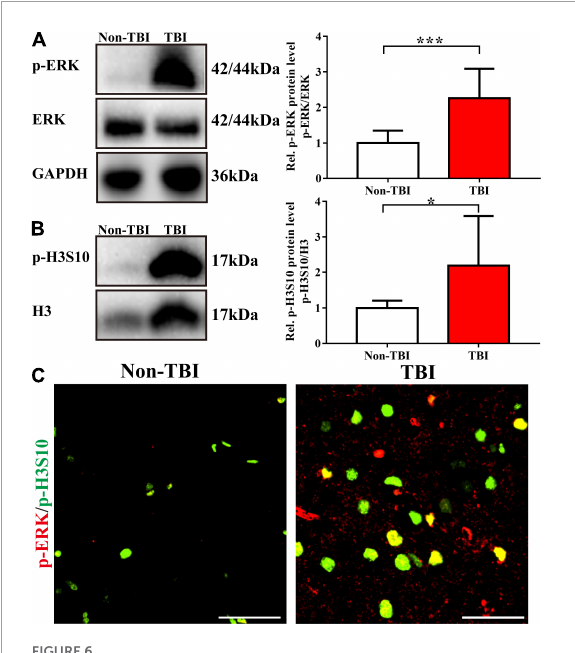
FIGURE6 Phosphorylation of H3S10 and ERK was upregulated in clinical brain specimens from patients with TBI. Western blot analysis showed that the levels of p-ERK (A) and p-H3S10 (B) in the brain tissue of TBI patients were significantly increased compared with those of non-TBI patients (For TBI patients, n = 11; for non-TBI patients, n = 6. Mann–Whitney test. * p < 0.05, *** p < 0.001. The values are expressed as the means ± SD). (C) Immunofluorescence images showing the high levels of p-H3S10 and p-ERK and their colocalization. Scale bar = 50 µ